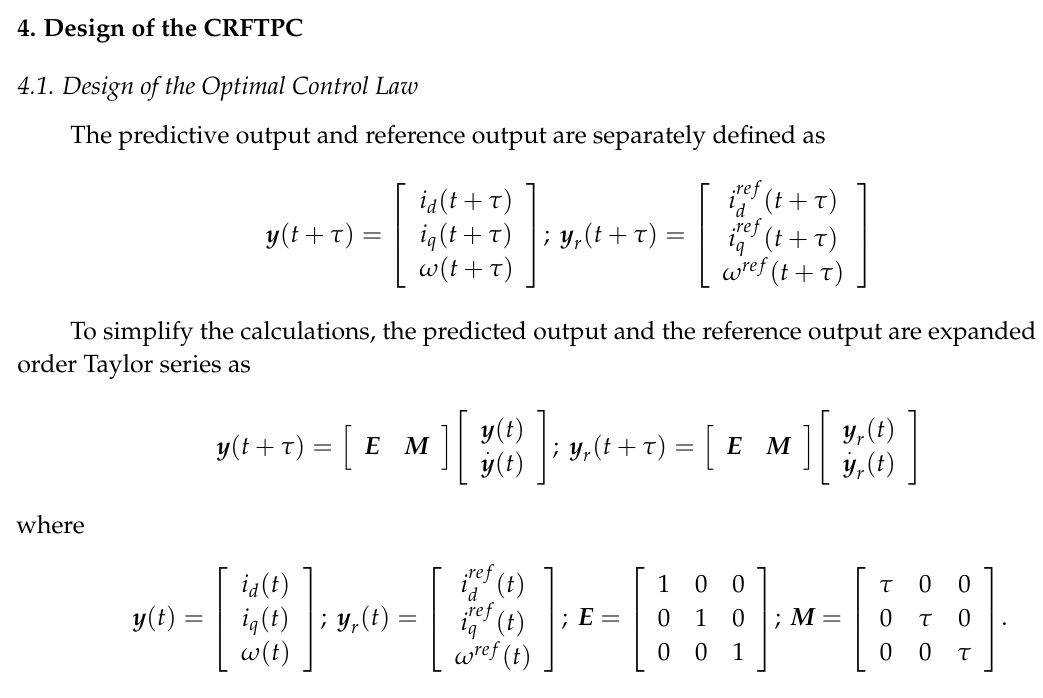
Figure 3. d -and q -axis disturbance: ( a ) resistance parameter perturbation; ( b ) inductance parameter perturbation and ( c ) permanent magnet demagnetization.